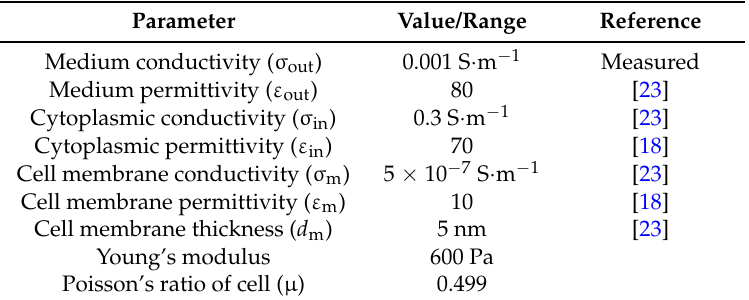
Table 1. Values of the constants and parameters used in the